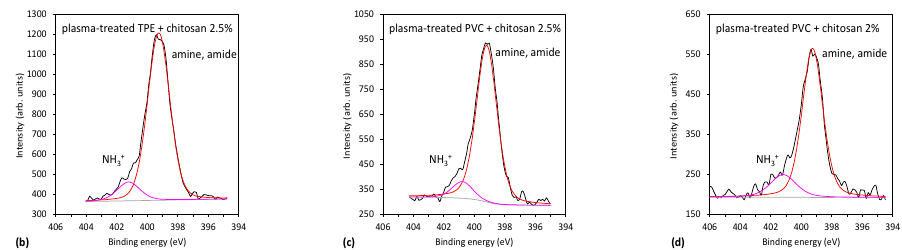
Figure 8. Comparison of XPS spectra of untreated and uncoated PVC catheters with coated cathe- ters: ( a ) soaking in 2% chitosan solution without plasma treatment; ( b ) soaking in 2.5% wt. macro- molecular chitosan solution without plasma treatment; ( c ) 2% chitosan coating with two-step plasma treatment; ( d ) 2.5% wt. chitosan coating with two-step plasma treatment; and ( e ) comparison of nitrogen spectra for all coated PVC catheters.